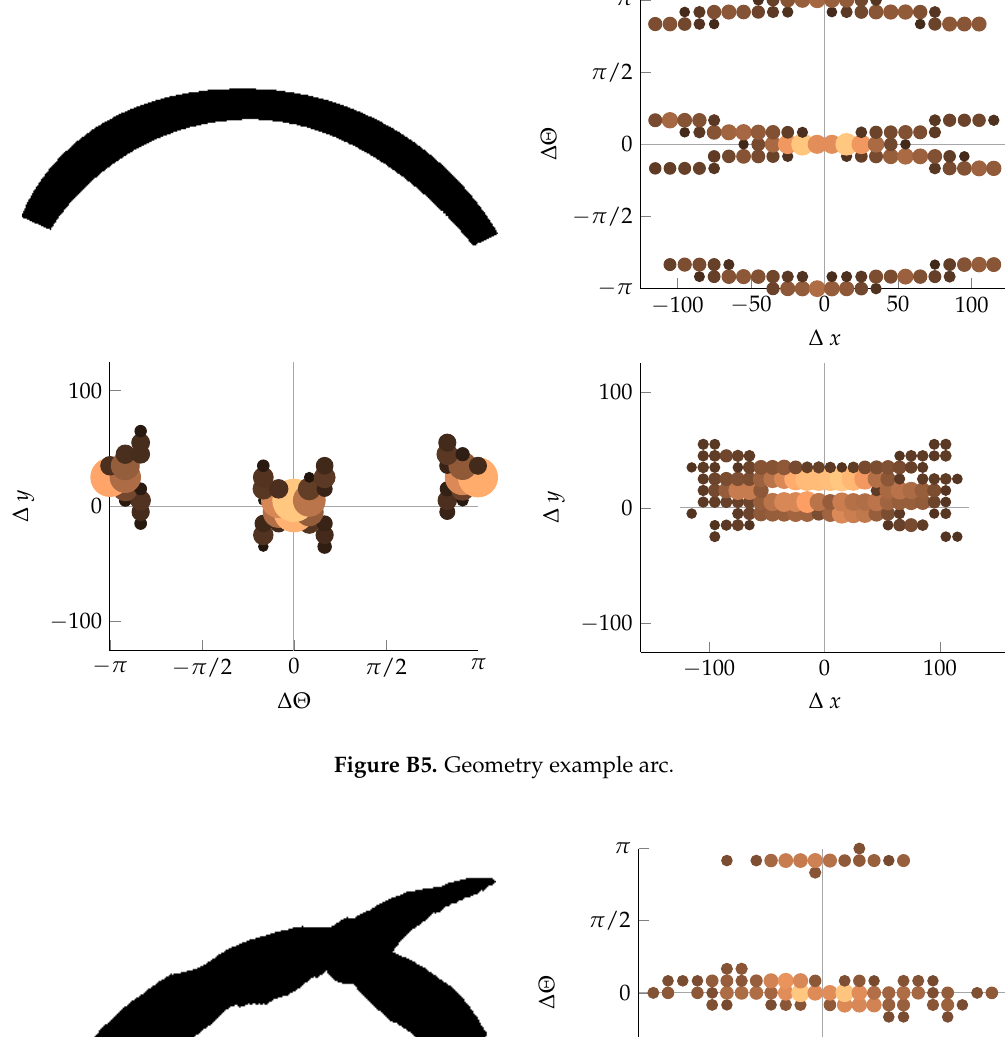
Figure B5. Geometry example arc.